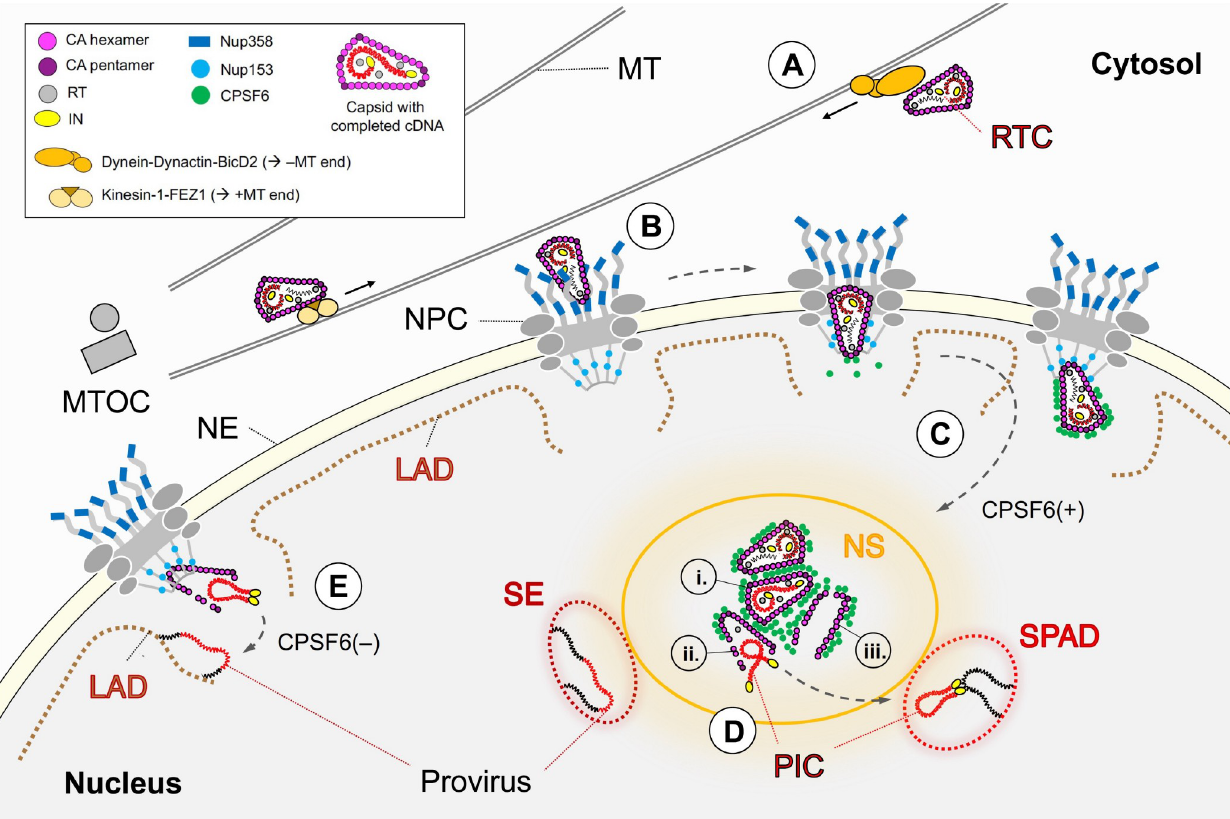
Fig 1. Early postentry steps of HIV-1 replication. (A) After fusion-mediated release of the HIV-1 capsid into the cytosol, reverse transcription of the viral RNA genome into double-stranded cDNA commences (RTC), and the capsid interacts with dynein and kinesin-1 motor complexes for transport along MTs toward the nuclear envelope (reviewed in [14]). (B) At the cytosolic side of NPCs, MT-associated capsids encounter Nup358 (blue rectangles), a major component of filaments emanating from the NPC. After docking at the nuclear pore with their narrow end, capsids then penetrate into the NPC central channel, which is sufficiently dilated to accommodate the complete capsid. (C) Once exposed to the nucleoplasm, sequential interaction of the CA lattice with Nup153 (blue dots) and CPSF6 (green dots) (and possibly other factors) releases the capsid into the nucleoplasm. CPSF6 mediates accumulation of capsids in NSs, where cDNA synthesis is completed (i). Inside the nucleus, the capsid structure is physically disrupted and the PIC is released (ii). (D) The PIC then separates from the capsid remnants (iii) and integrates into the host cell genome in SPADs or SE domains (reviewed in [10,31]). (E) In the absence of CPSF6, the capsid remains close to the nuclear basket and does not efficiently enter the nucleoplasm. Completion of cDNA synthesis and uncoating occur at this site, followed by breakage of the capsid and genome integration into LADs [10]. CA, capsid protein; HIV-1, human immunodeficiency virus 1; LAD, lamin-associated domain; MT, microtubule; MTOC, microtubule organizing center; NE, nuclear envelope; NPC, nuclear pore complex; NS, nuclear speckle; PIC, preintegration complex; RTC, reverse transcription complex; SE, super-enhancer-rich domain; SPAD, speckle-associated domain.